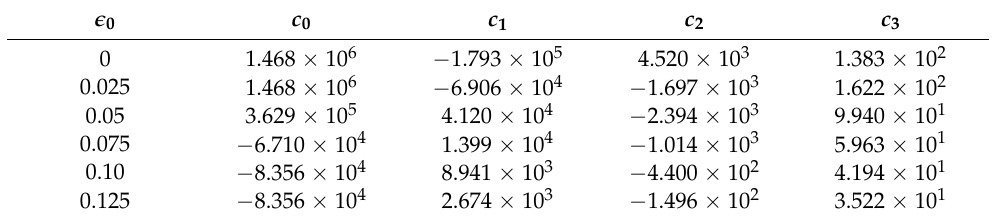
Table 2. Coefficients for Equation (4) to describe the strain–resistance relationship during tension.